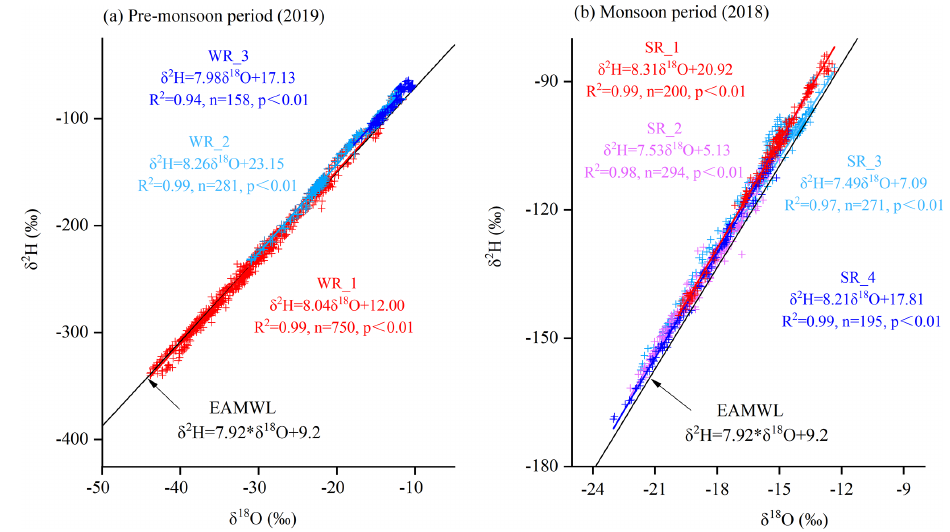
Figure 9. Regional patterns of vapor δ 18 O– δ 2 H relation during pre-monsoon period (a) and monsoon (b) period, compared with the East Asia meteoric water line (EAMWL) (Araguás-Araguás et al., 1998).